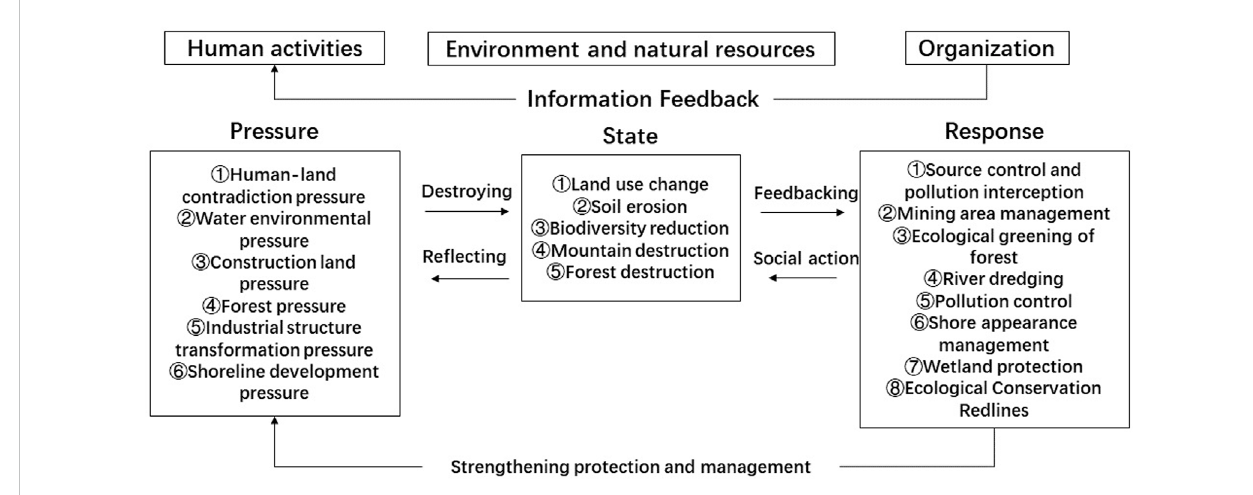
FIGURE 4 “ Pressure-State-Response ” framework of ecological